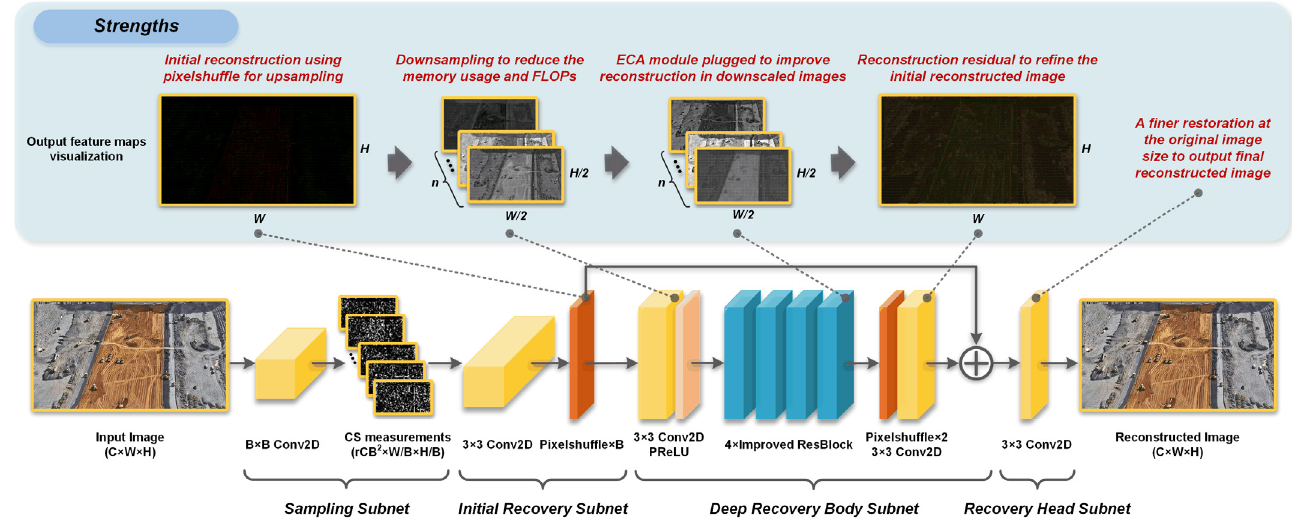
Figure 1. EHDCS-Net